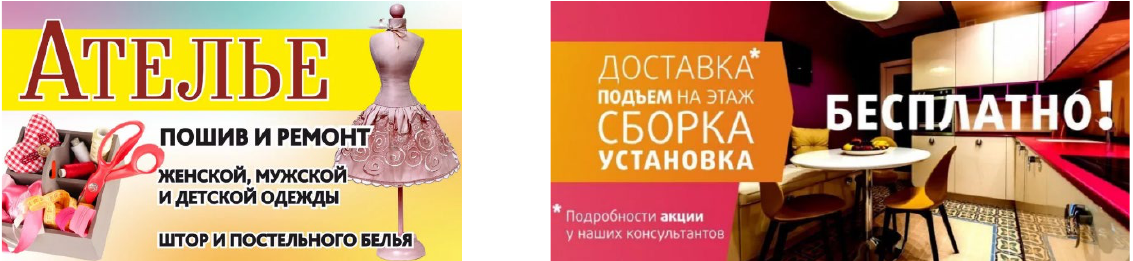
Figure 4 – Examples of advertising with mononuclear sentences